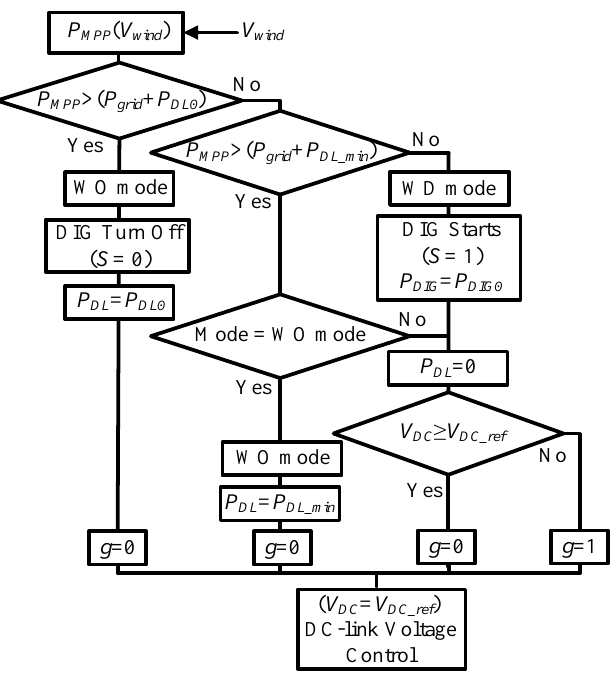
Figure 6. Flowchart of the proposed operational approach.